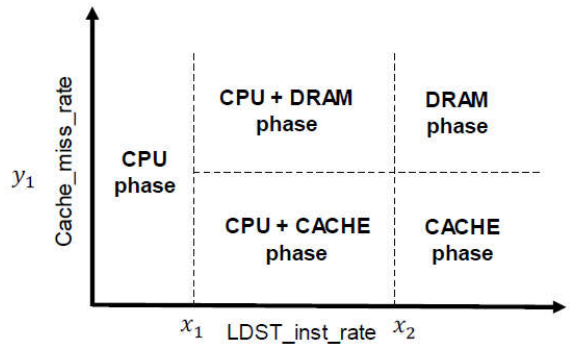
Figure 3. Visualization of CPU phase classification [5].